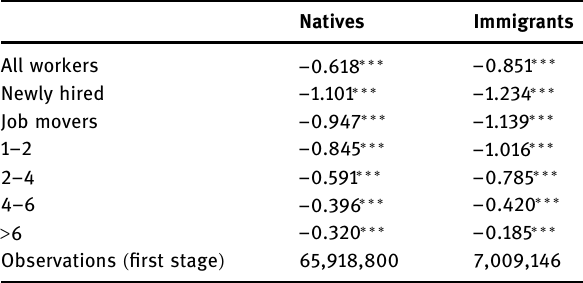
Table 6: Wage cyclicality for selected samples